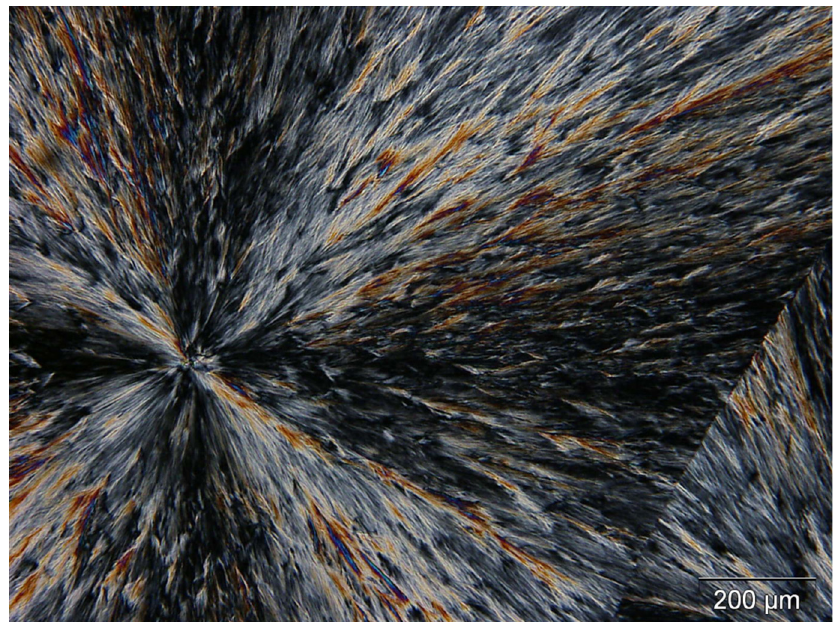
Figure 3. PEG spherulites observed by optical microscopy in combination with polarized light at ambient temperature.